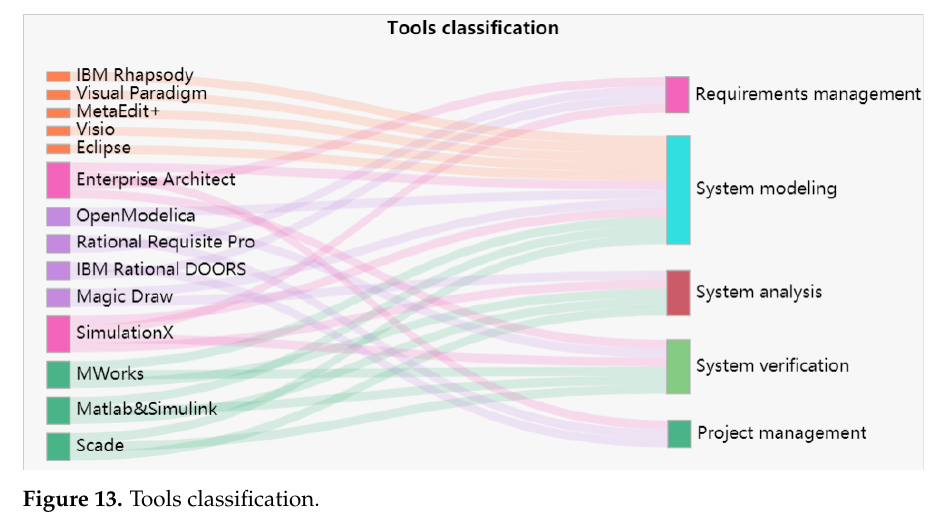
Figure 13. Tools classification.